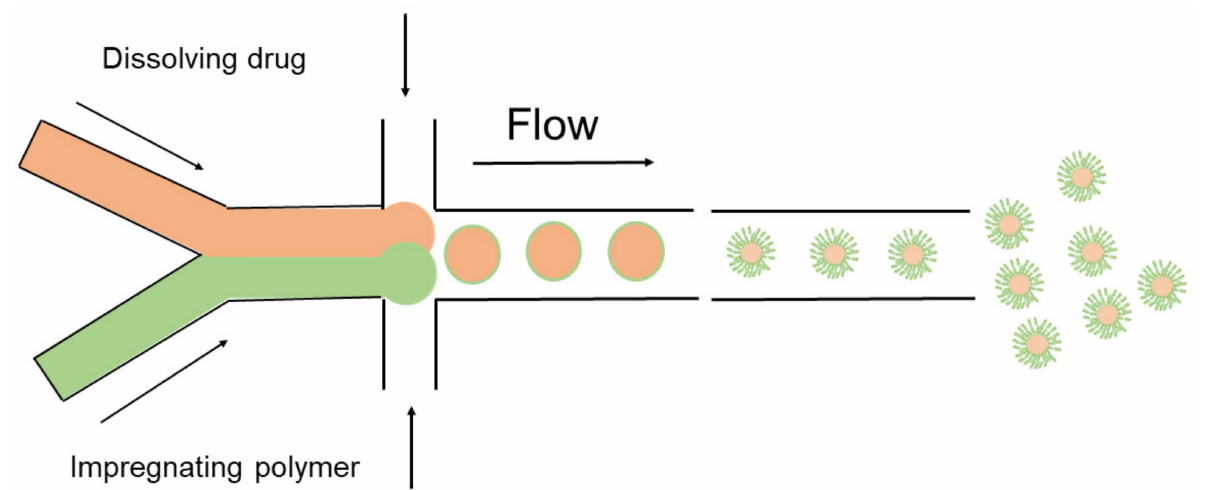
Figure 8. Schematic illustration of the microfluidics method. Nanoparticles are formed in the central channels of the microchips where the continuous phase meets the dispersed phase (adapted from Han. et al., 2016